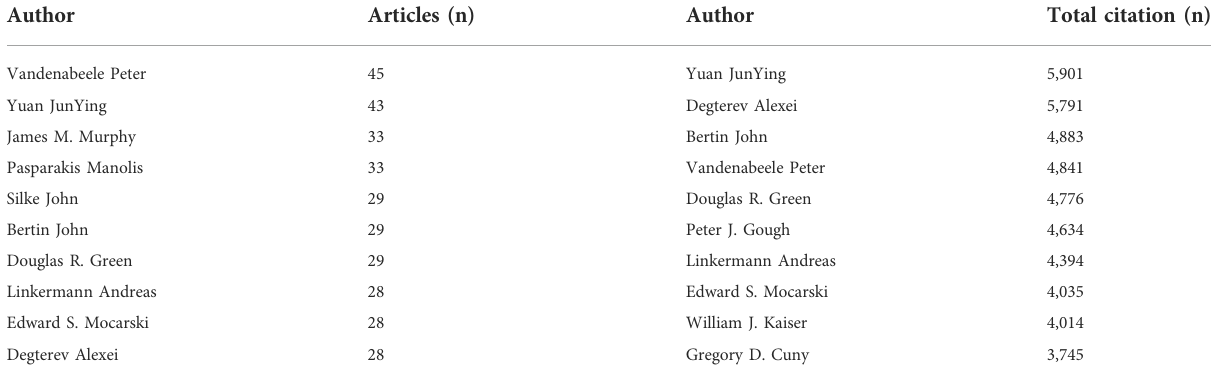
TABLE 1 The top 10 productive authors and the most-cited authors in the fi eld of